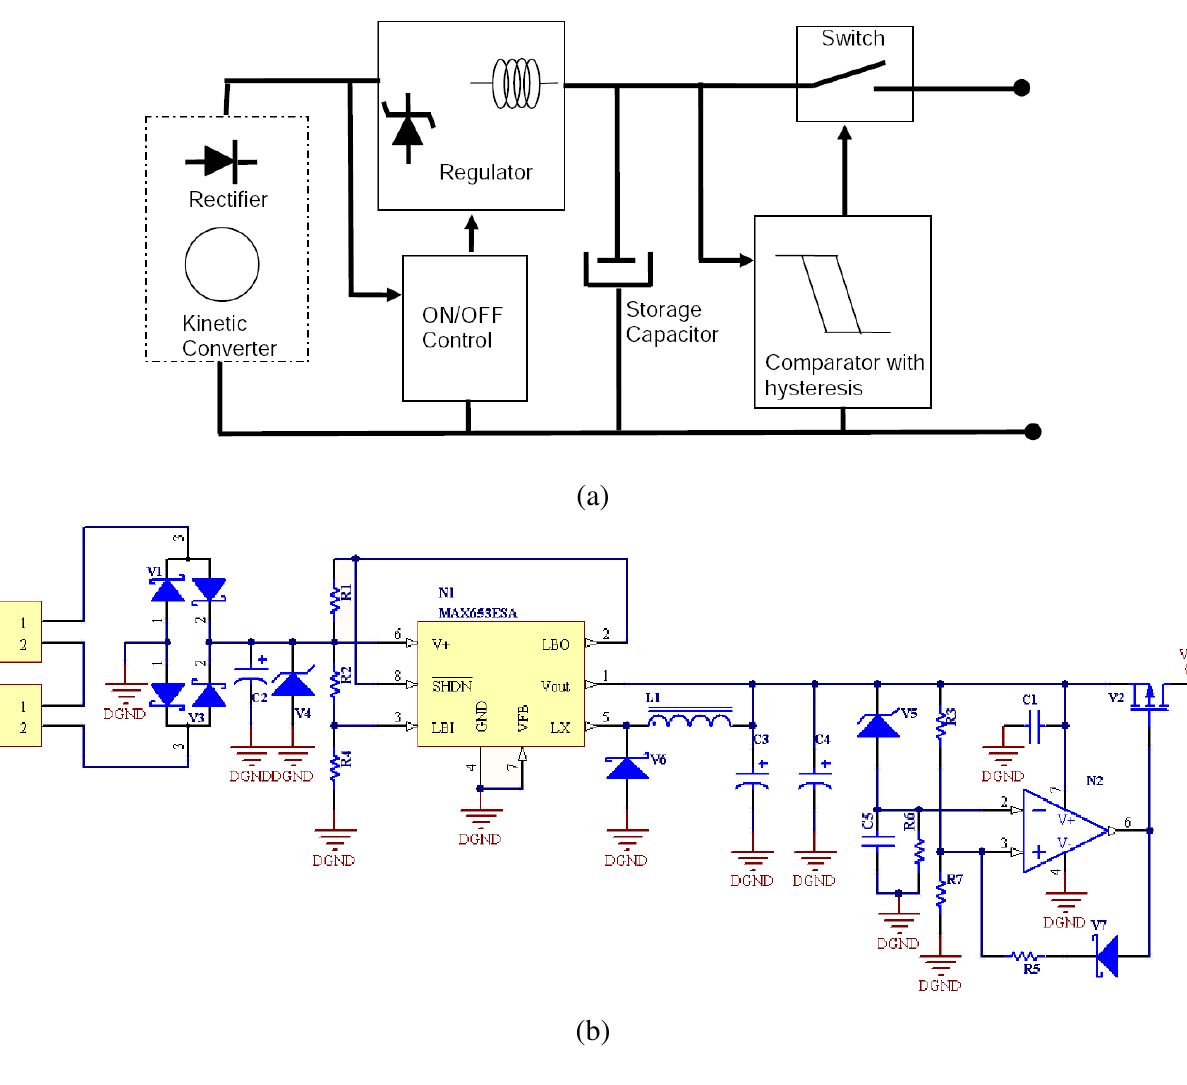
Figure 4. (a) Block and (b) Schematic diagram of the kinetic harvester